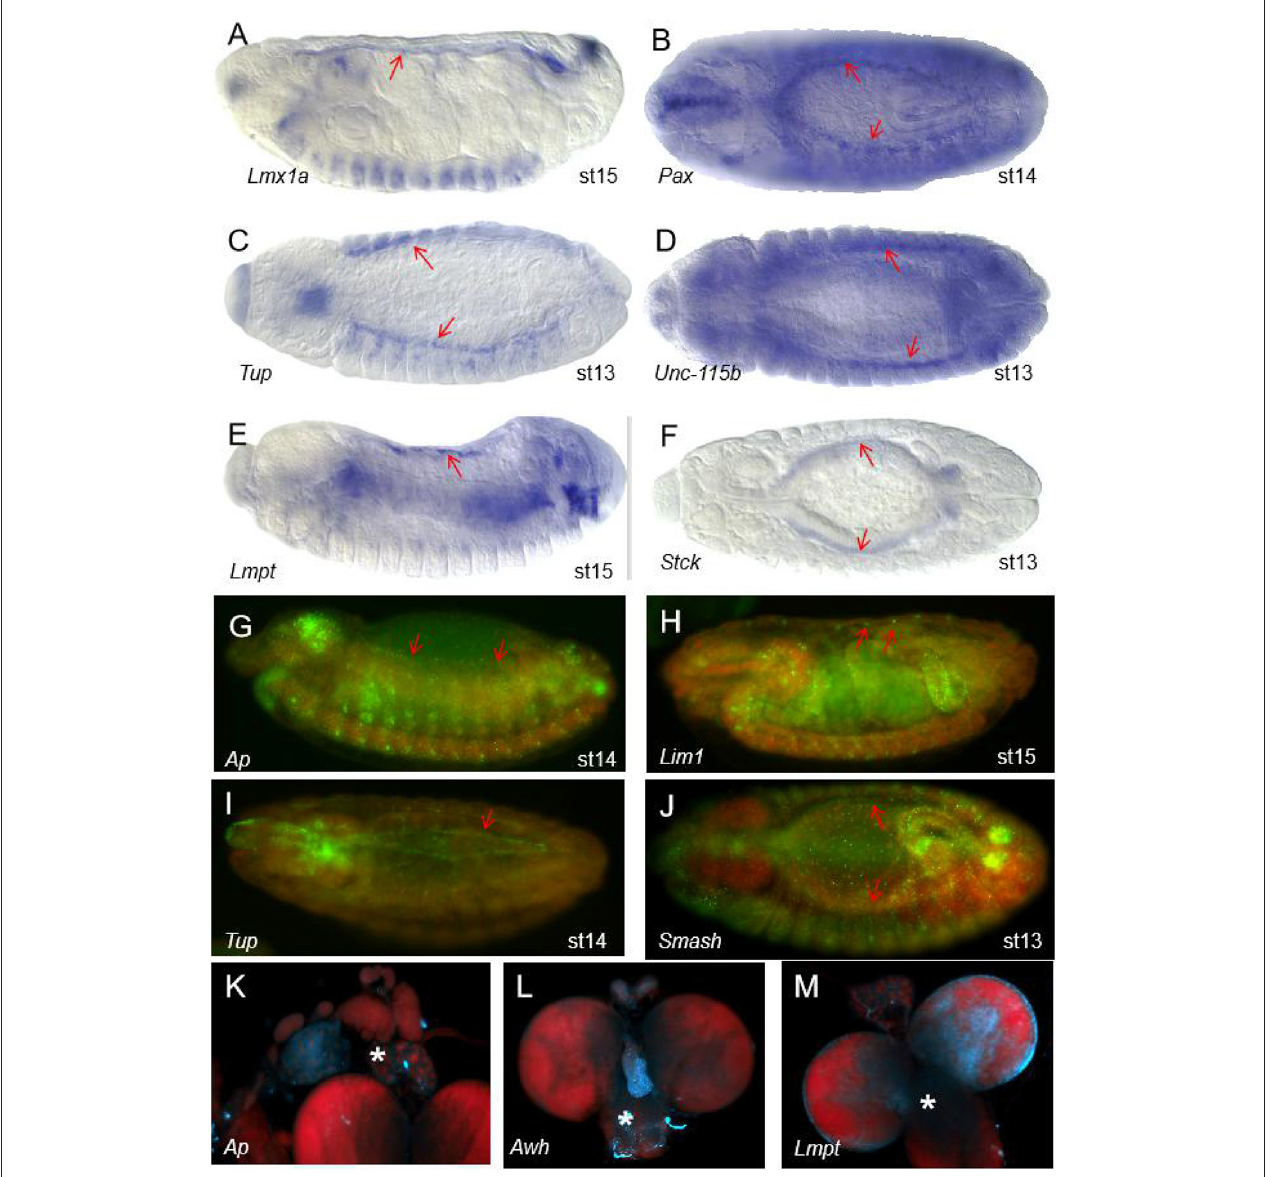
FIGURE 2 | The expression patterns of some of the 36 LIM genes in Drosophila melanogaster . (A–F) Expression patterns of some genes with the LIM domain in wild type (WT) Drosophila embryos from the FlyExpress (ISH) database. The red arrows represent the heart region of the fruit fly embryo. Embryos are at stage 13–15 of development. Lmx1a (A) , Pax (B) , Tup (C) , Unc-115b (D) , Lmpt (E) , and Stck (F) are expressed in Drosophila heart tissue. (G–J) Expression patterns of some genes with the LIM domain in Drosophila embryos in the Fly-FISH database. The red arrows represent the heart region of the fruit fly embryo. Embryos are at stage 13–15 of development. Ap (G) , Lim1 (H) , Tup (I) , and Smash (J) are expressed in Drosophila heart tissue. Embryo colors: Red/DNA, Green/RNA. (K–M) The area of the lymph glands in the anatomy. Expression patterns of some genes with the LIM domain in the third larvae of Drosophila in the Fly-FISH database. The white asterisk represents the lymph gland region of the fruit fly larvae. Ap (K) , Awh (L) , and Lmpt (M) are expressed in Drosophila lymph gland. Larval colors: Red/DNA,